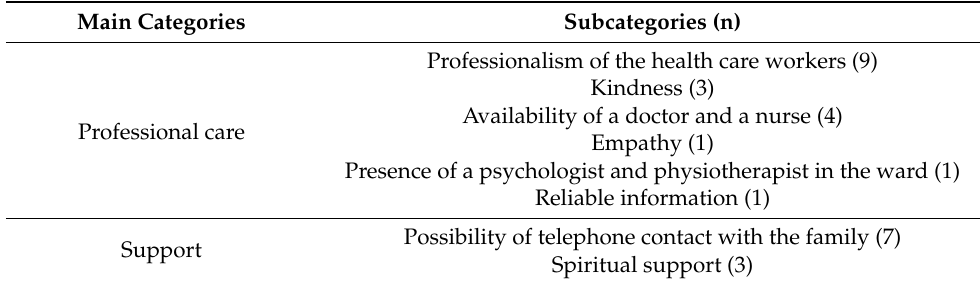
Table 3. Hospitalized patients’